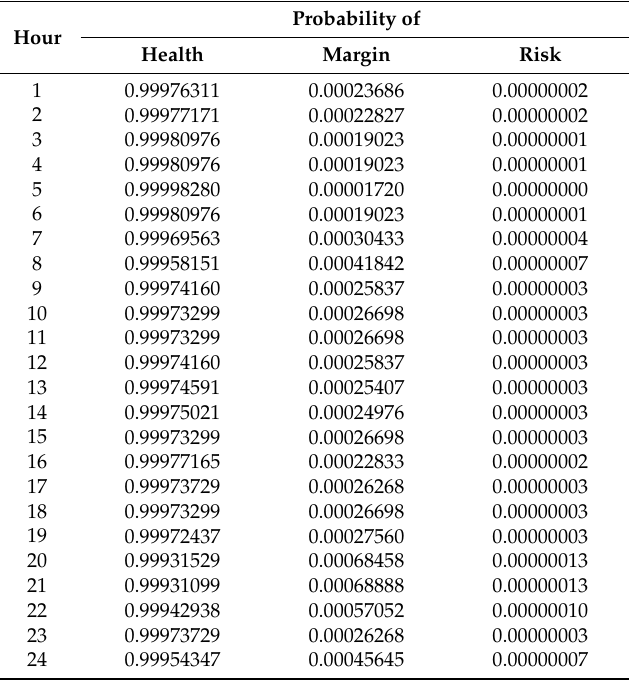
Table 5. System well-being with five reserved units.